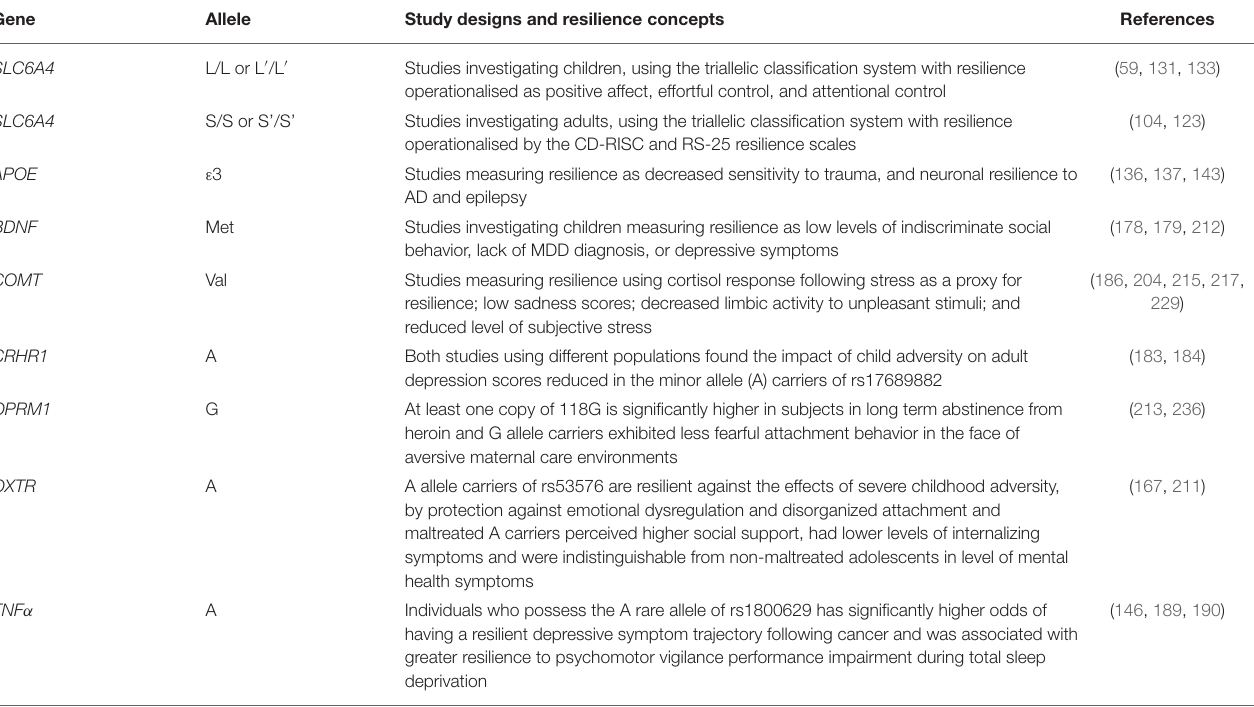
TABLE 4 | Genetic variants associated with resilience in humans and animals reaching consensus.